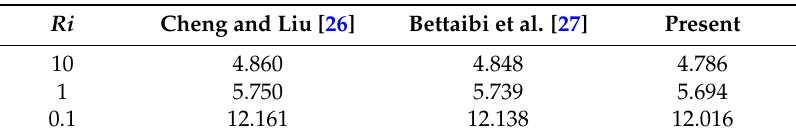
lid-driven cavity.